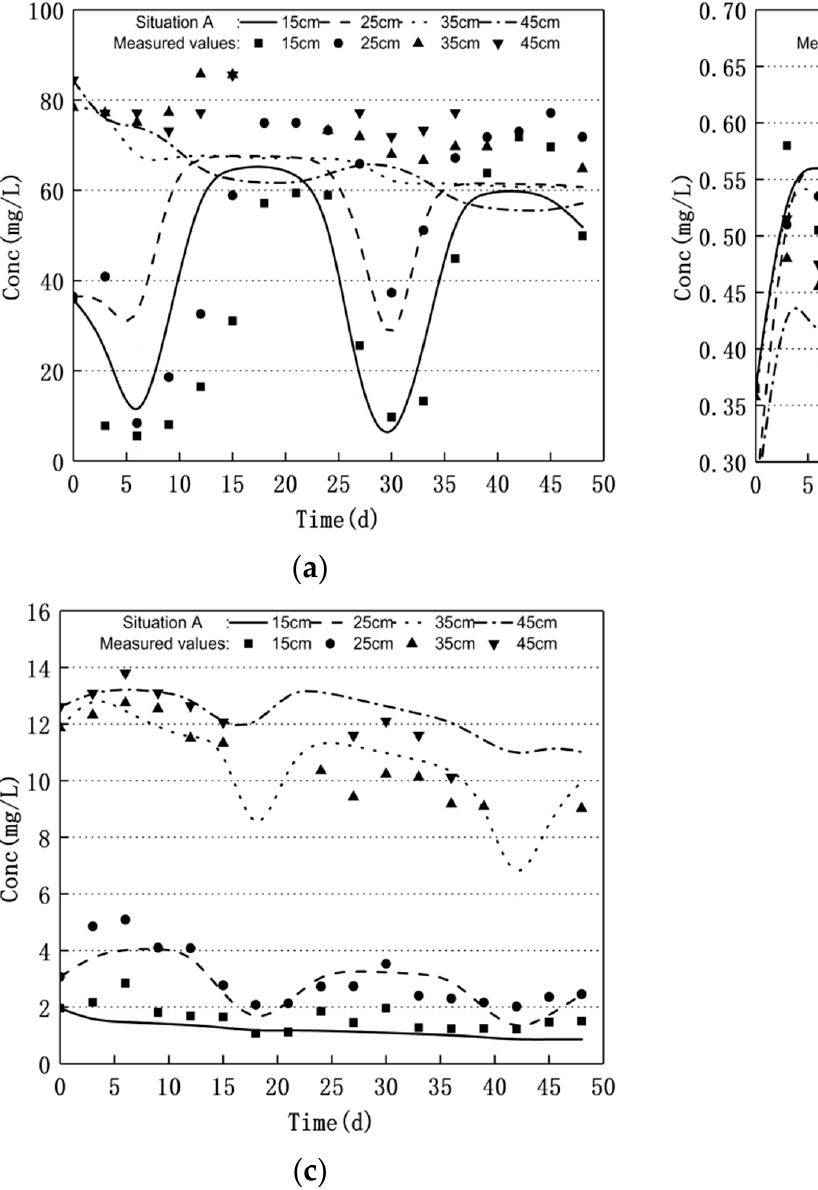
Figure 9. The measured results of medium sand and the dynamic process of nitrogen in situation A